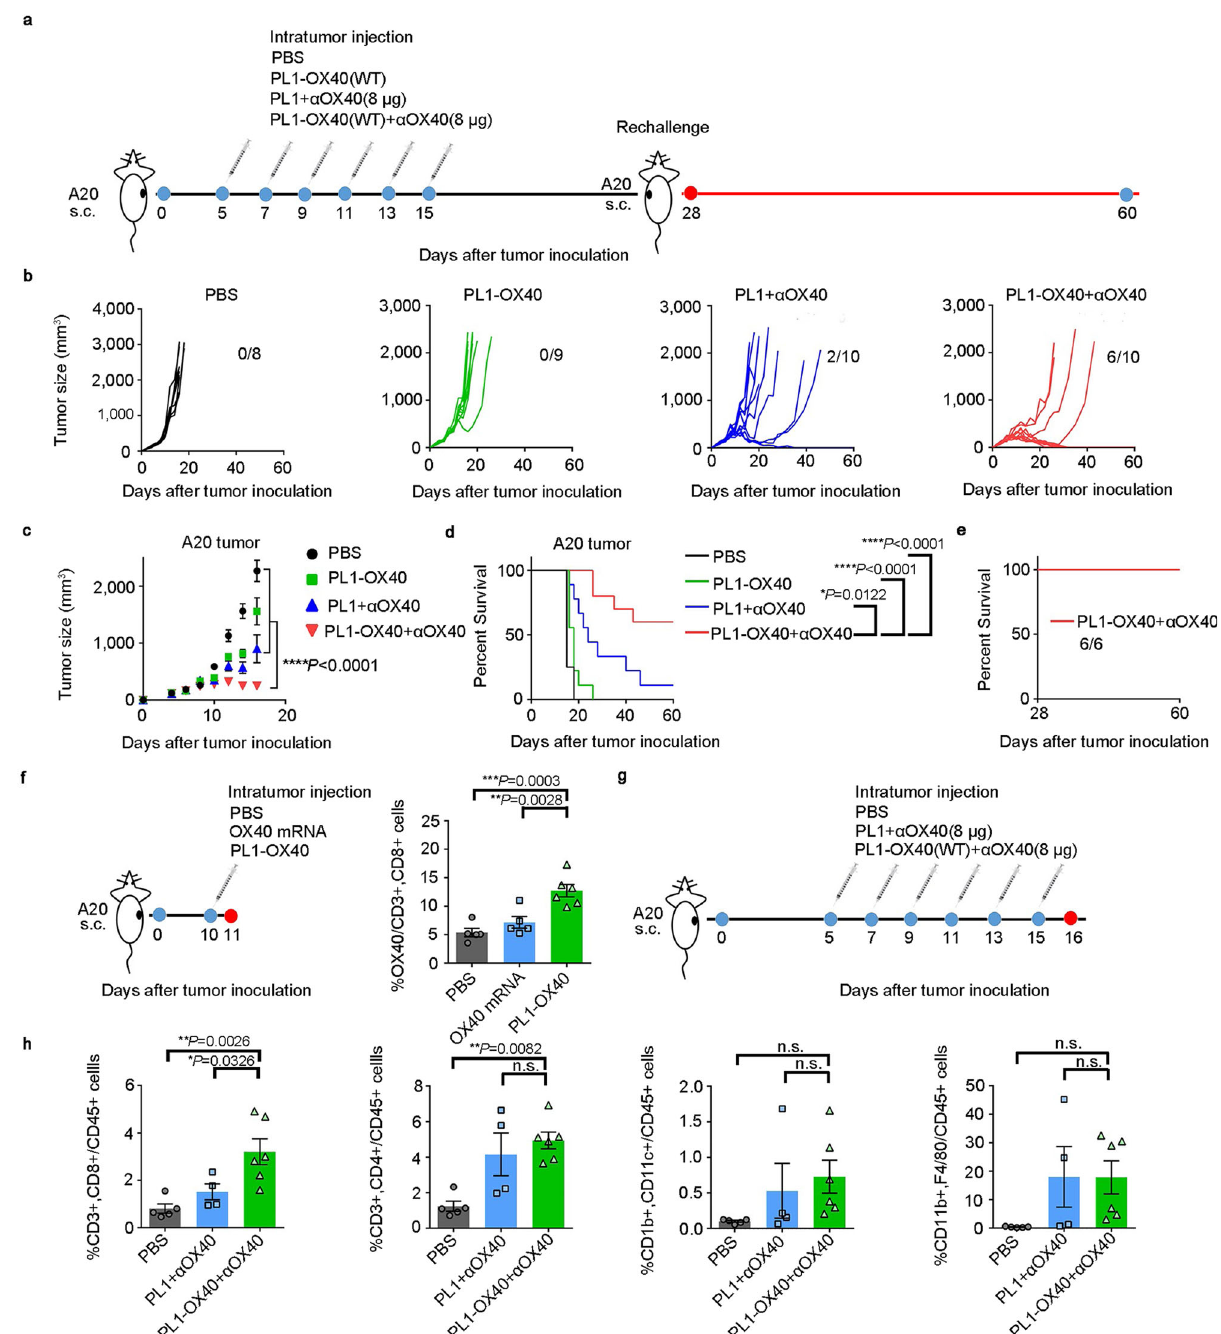
Fig. 3 Regression of A20 tumors after treatment with PL1-OX40 + anti-OX40 antibody. a Schematic illustration of the A20 mouse tumor model and the treatment regimen. b Tumor volumes of individual mice ( n = 8 – 10) after i.t. injected six doses of PBS, PL1-OX40, PL1 + anti-OX40 Ab, or PL1-OX40 + anti- OX40 Ab. PL1-OX40 (10 µ g mRNA/mouse), and anti-OX40 Ab (8 µ g/mouse). c , d Tumor volumes ( c ) and overall survival ( d ). n = 8 mice in PBS group, n = 9 mice in PL1-OX40 group, n = 10 mice in PL1 + anti-OX40 Ab group, and n = 10 mice in PL1-OX40 + anti-OX40 Ab group. e Overall survival of rechallenged mice. On day 28, rechallenge mice ( n = 6) with complete response after the treatment with PL1-OX40 + anti-OX40 Ab. f Treatment plan for evaluation of OX40 expression on the CD8 + T cells after a single i.t. injection with PBS ( n = 5), OX40 mRNA ( n = 5), or PL1-OX40 ( n = 6). g , h Immune cell analysis (CD8 + , CD4 + T cells, macrophage, DC) after six i.t. injections with PBS (n = 5), PL1 + anti-OX40 Ab ( n = 4), or PL1-OX40 + anti-OX40 Ab ( n = 6), respectively. Data in c , f , and h are presented as the mean ± S.E.M. Statistical signi fi cance in c was analyzed with two-way ANOVA. Statistical signi fi cance in d was analyzed using the log-rank (Mantel-Cox) test. Statistical signi fi cance in f and h was analyzed using one-way ANOVA followed by Dunnett ’ s multiple comparison test. * P < 0.05; ** P < 0.01; *** P < 0.001; **** P < 0.0001; n.s., not signi fi cant. Source data are provided as a Source Data fi le.